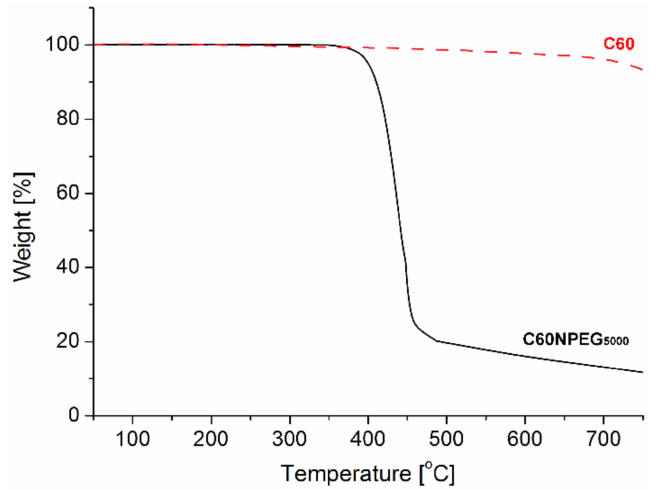
Figure 4. The TGA curves registered for C60NPEG 5000 and C 60 fullerene at 10K/min in N 2